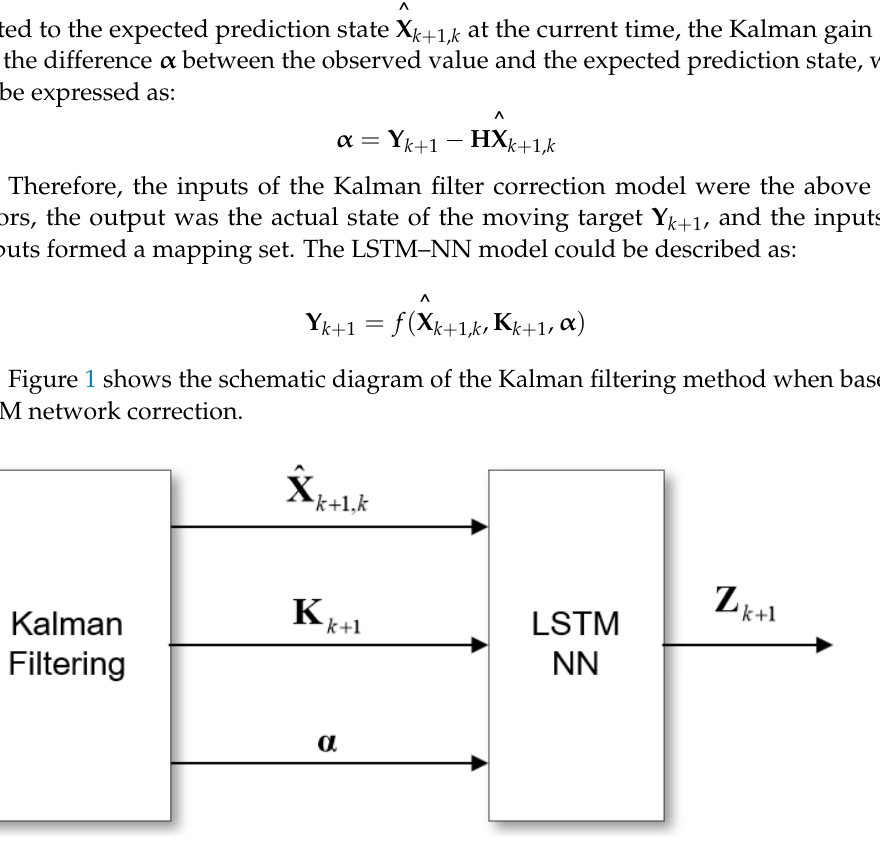
Figure 1. The schematic diagram of the LSTM–Kalman filtering method.